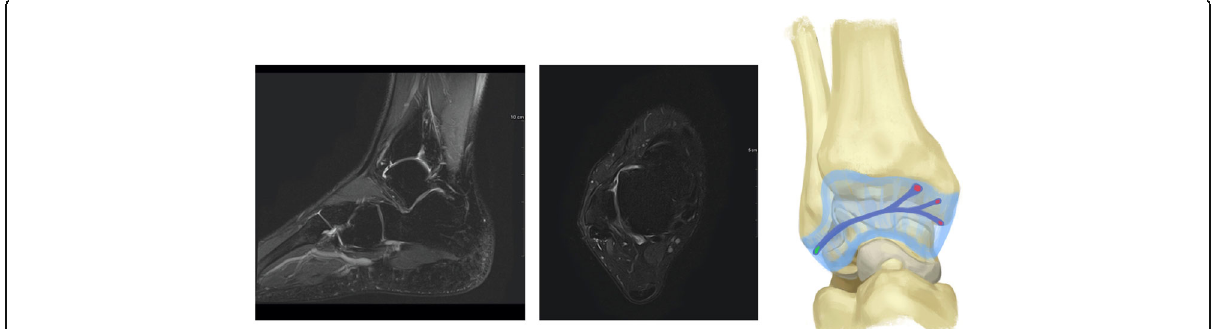
Fig. 5 Sagittal and axial MRI views, and the shape of the fibrous band in patient 4